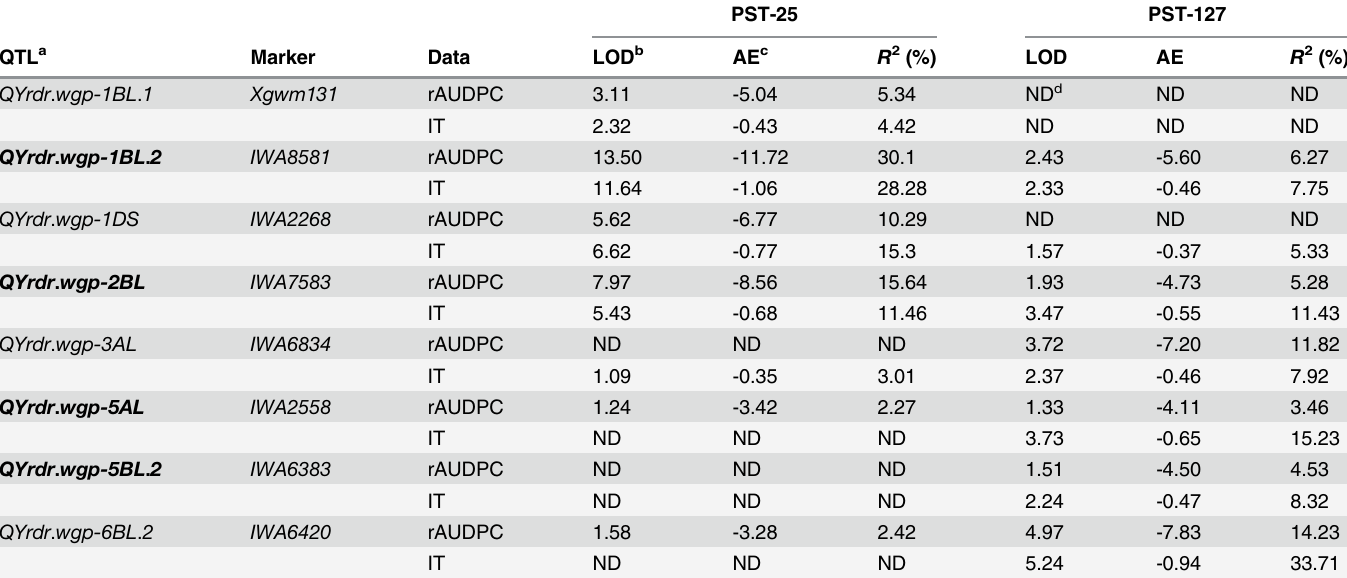
Table 6. Quantitative trait loci (QTL) for stripe rust resistance based on relative area under the disease progress curve (rAUDPC) and infection type (IT) data detected in the Druchamp × Michigan Amber-derived recombinant inbred line population at adult plant stage inoculated with races PST-25 and PST-127 of Puccinia striiformis f. sp. tritici in greenhouse under the high-temperature